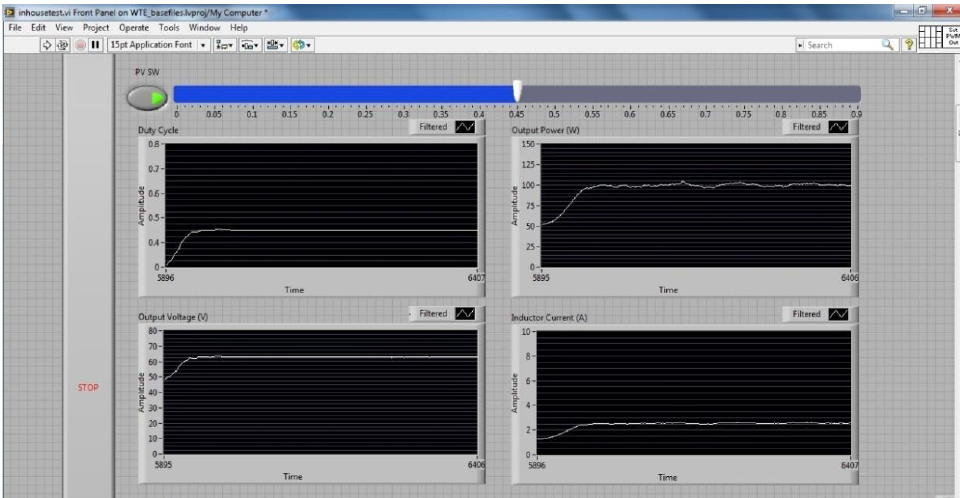
Figure 19. The front window of Labview Figure 19. The front window of Labview . The left-hand side top window exhibits the duty cycle modulation and becomes sta- ble at D = 0.45 when its operating point approaches MPP, corresponding to a solar isola- tion of 648 W/m 2 (13:00). The right-hand side top window shows the measured PV array output power across the load. The lower LHS window shows the PV output voltage as 62.5 V, whereas the RHS window displays the inductor current of the boost converter in continuous conduction mode. The results across the load resistance of 40 Ω were taken on the YOKOGAWA digital signal oscilloscope DL750 , as shown in Figure 20. Figure 20. Results (for 13:00) obtained by hardware implementation: CH1 : voltage across the load resistance (62.5 V); CH2 : current across the load (1.6 A); and CH3 : solar PV array’s terminal voltage ( V PV = 34.9 V).